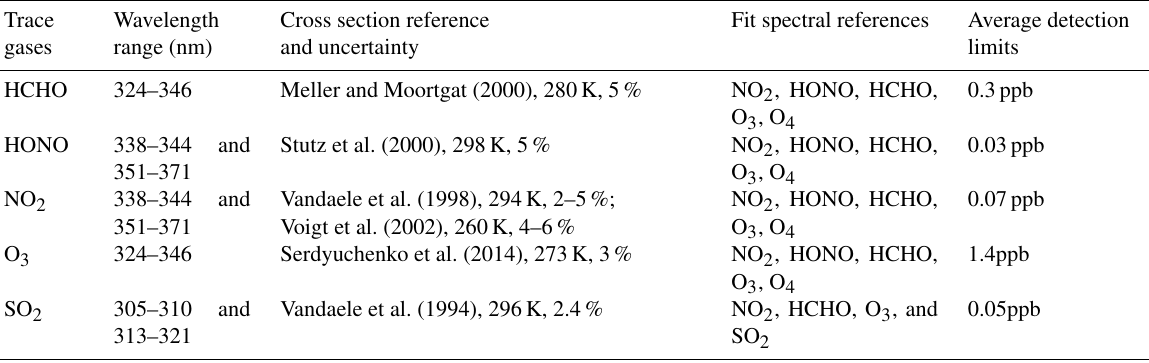
Table 1. Wavelength windows, cross sections, and fitted trace gases used for DOAS retrieval during UBWOS 2012. The quoted detection limits are campaign